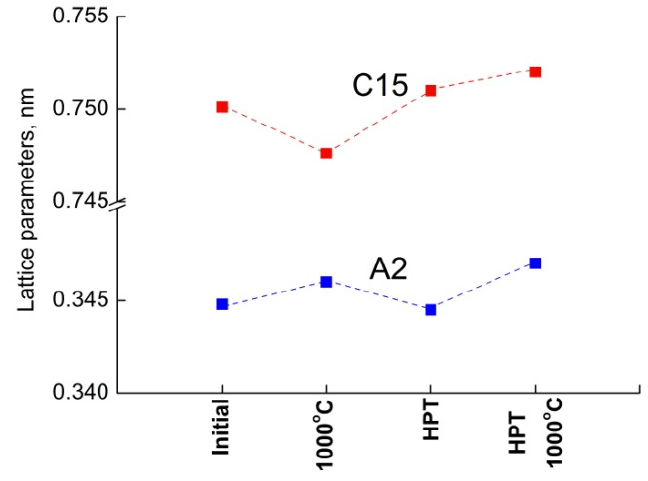
Figure 12. Dependence of the lattice parameter on the type of material processing of the TiZrHfMoCrCo alloy.